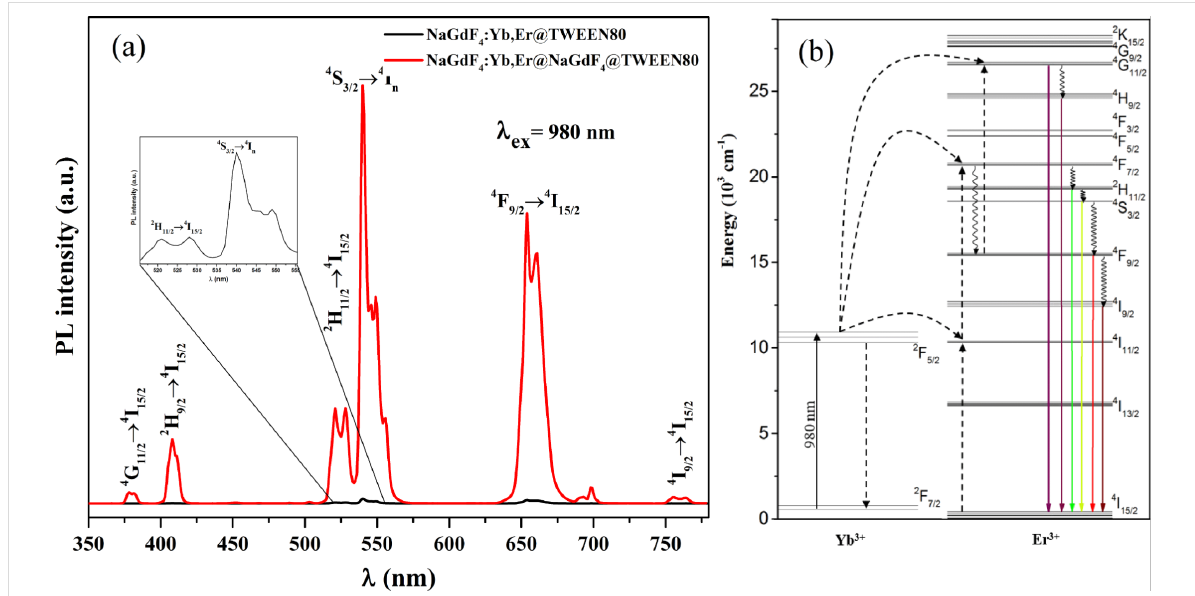
Figure 4: (a) Upconversion luminescence spectra of Tween 80-coated UCNPs upon 980 nm excitation [28] and (b) energy level diagram of Yb 3+ and Er 3+ ions.